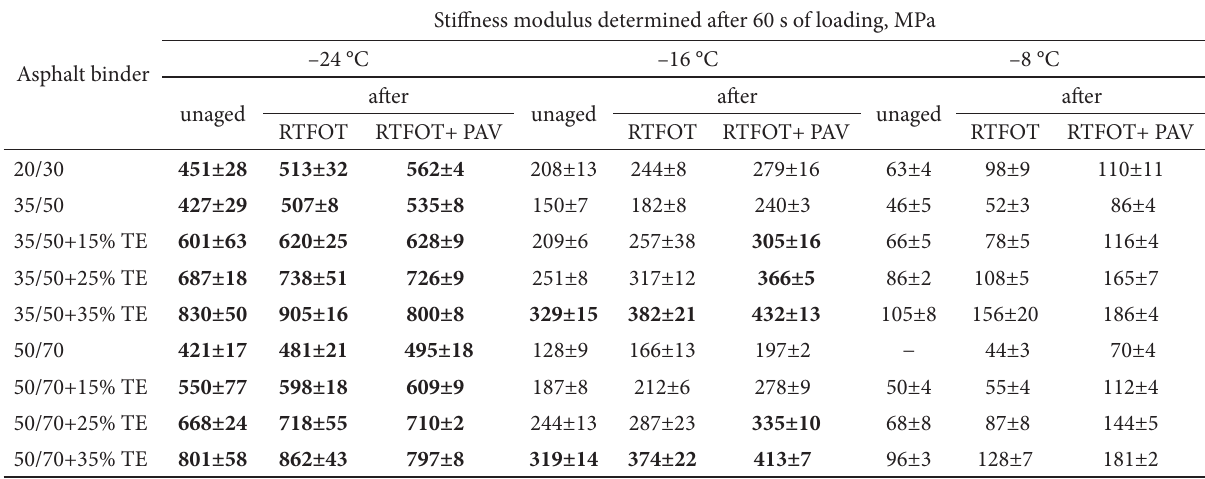
Table 4. Results of the stiffness modulus determination at –24 °C, –16 °C and –8 °C for the Trinidad Epuré modified asphalt binders